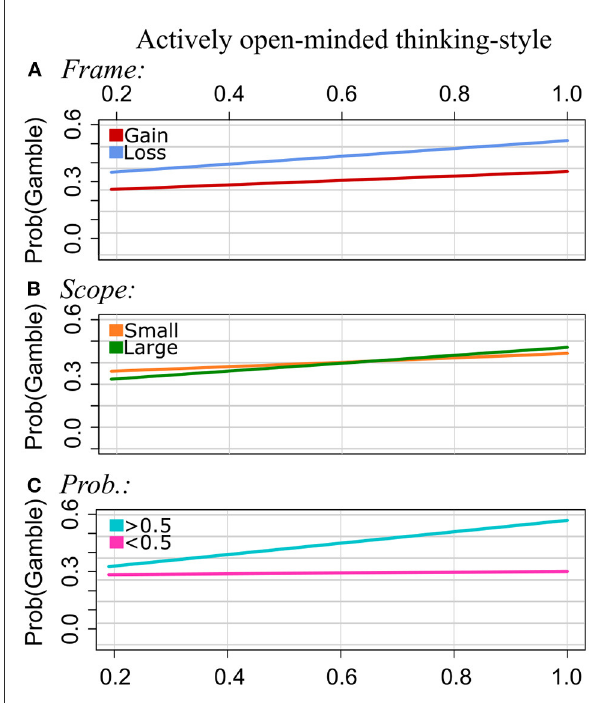
FIGURE5 Experiment 2: Regression lines of the proportion of choosing the gamble option as a function of AOT, separately for the levels of Frame [pattern (A) ], Scope (B) , and Probabilities (C) .